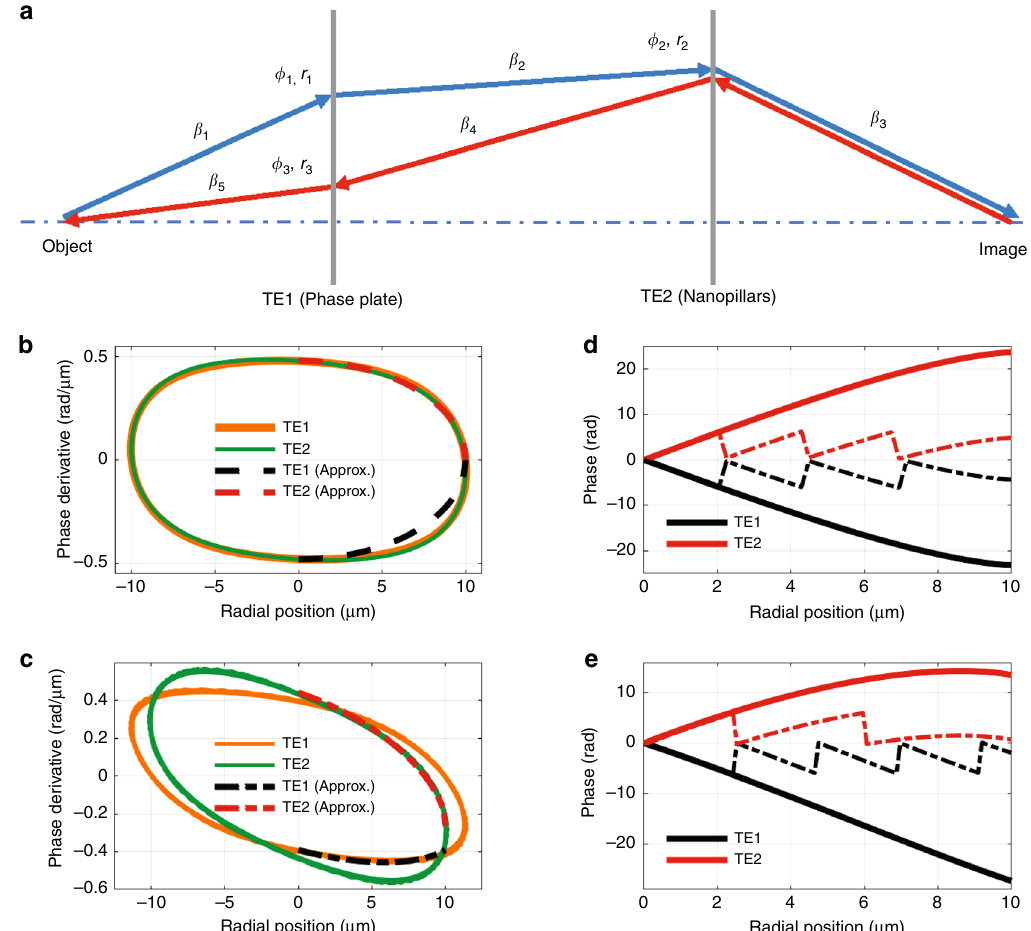
Fig. 2 Design process for hybrid achromatic metalenses. a The phase derivative vs. position of the two optically thin elements (TE1: phase plate, and TE2 nanopillar metalens) are determined using recursive ray tracing. First, rays are traced with λ from the object plane to the image plane (blue rays). min Then, rays are traced with λ from object to image (red rays). The process repeats until the design converges. b , c Phase derivative vs. radial coordinate for max both optical elements of merged and air-spaced metalenses, respectively. Closed loops spanning both positive and negative radial coordinates indicate convergence of the algorithm. Dashed lines represent an analytic approximation of the phase derivatives for each element. The fi rst and second quadrants represent diverging designs, while the third and fourth quadrants provide converging designs. d , e Phase shift vs. radial position for each element for a 20 μ m EPD lens with 0.27 NA (merged) and 0.35 NA (air-spaced), respectively. Dashed lines represent the wrapped phase of the fabricated thin